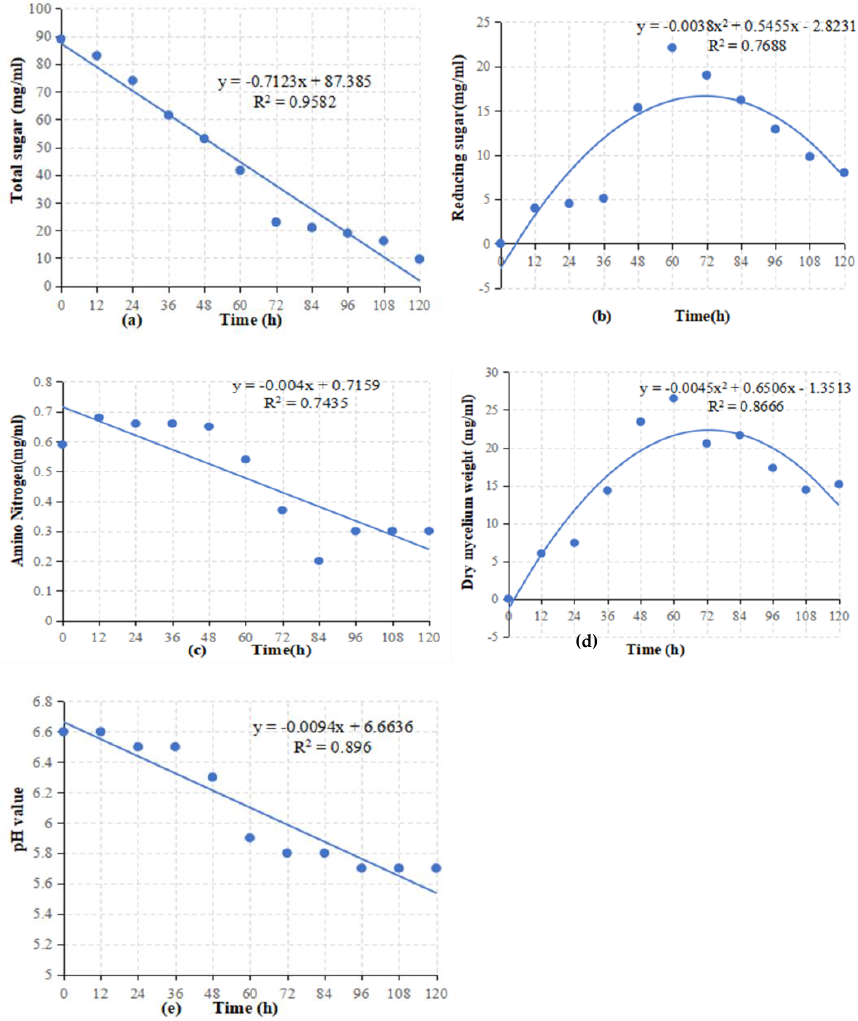
Figure 4. Metabolism study of submerged fermentation batch of BAM. Total sugar consumption ( a ), reducing sugar concentration ( b ), amino nitrogen ( c ), dry mycelium weight ( d ), pH values ( e ).